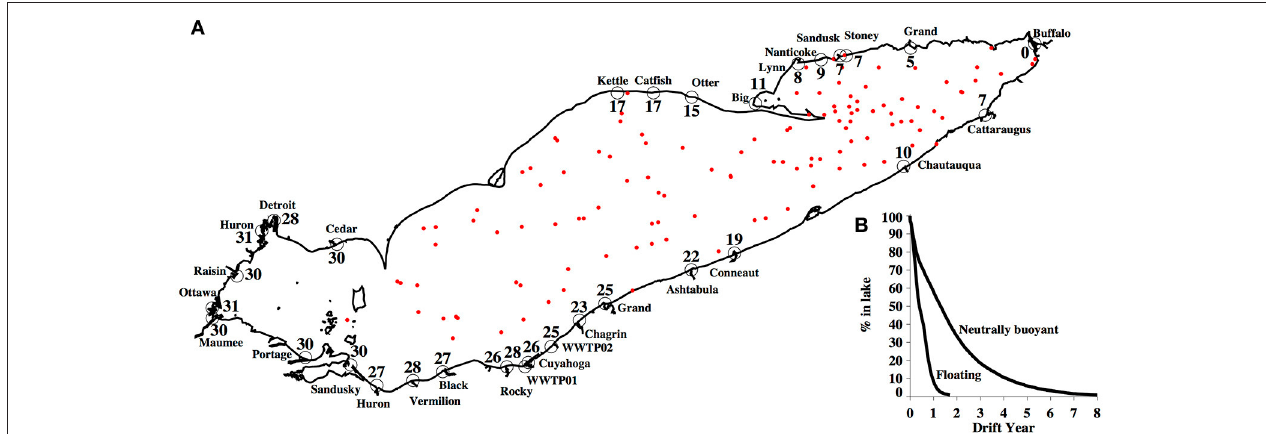
FIGURE 10 | (A) Mean residence time (months) for each source of neutrally buoyant particles. Particles were released daily for 1 year and tracked for 8 years (time for 99% of particles to leave the lake). Red dots represent the particles that remain in the lake after 8 years of drift. (B) Percent of particles remaining as a function of time for the neutrally buoyant (right curve) and floating (left curve) models; based on same run conditions as (A)